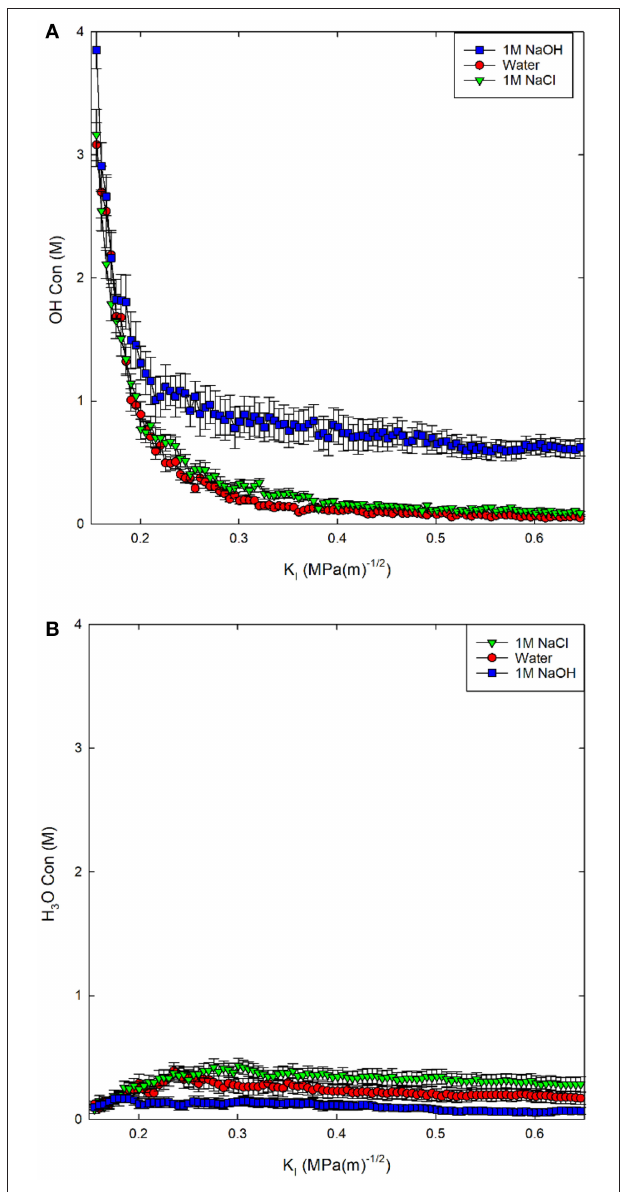
FIGURE 3 | (A) OH − concentration in solution and (B) H 3 O + concentration in solution reported as a molarity (M) for three environmental